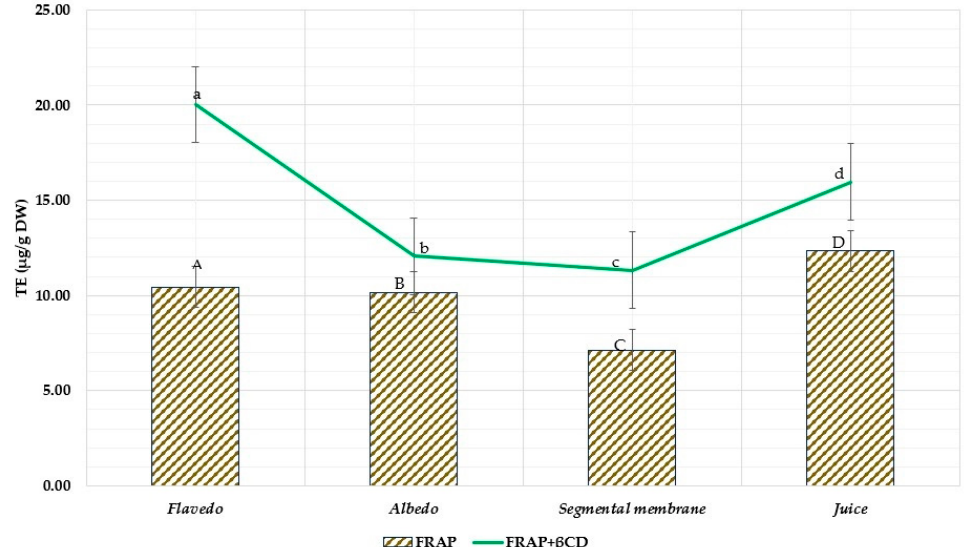
Figure 16. FRAP assay of ethanolic grapefruit extracts with excipients and without. The results are mean values ( n = 3). All the test samples (a, b, c, d) were statistically ( p < 0.05) significant to controls (A, B, C, D); D p < 0.05 A, B, C; a p < 0.05 b, c, d; d p < 0.05 c, d; A p < 0.05 B, C.